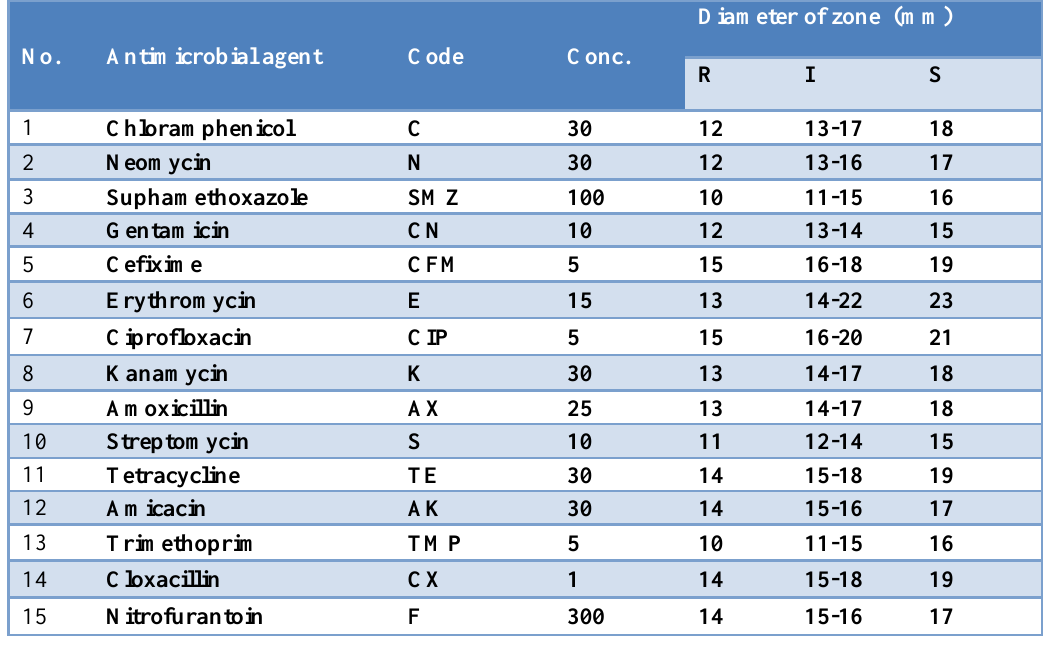
Table, 1: Antimicrobial discs used with their remarks